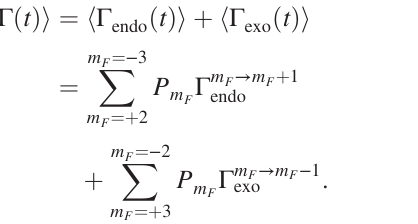
FIG. 11. Fluctuation of energy σ of the steady state of the spin E population of the probe as a function of the temperature T for a fixed magnetic field B : (a) B ¼ 25 mG, (b) B ¼ 40 mG, (c) B ¼ 60 mG, (d) B ¼ 80 mG. The dots are the theoretical points, and the dashed lines represent the linear